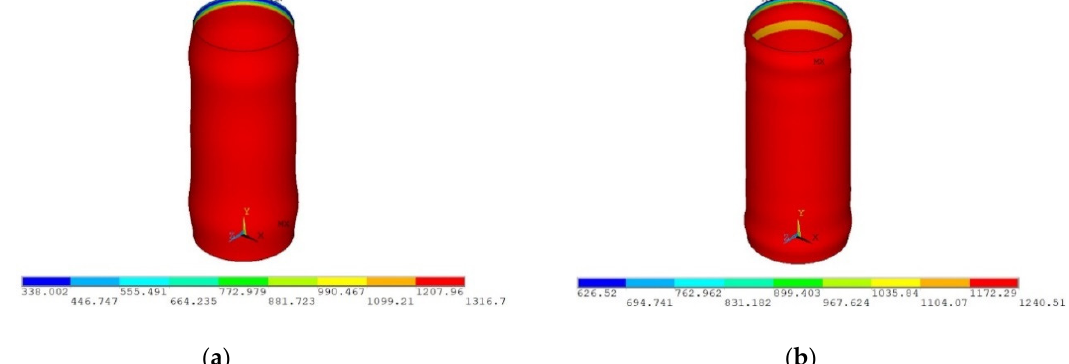
Figure 10. Cont S460). ( a ) 𝐷 𝑡⁄ = 10 . ( b ) 𝐷 𝑡⁄ = 100 . ( c ) 𝐷 𝑡⁄ = 110 . ( d ) 𝐷 𝑡⁄ = 250 .